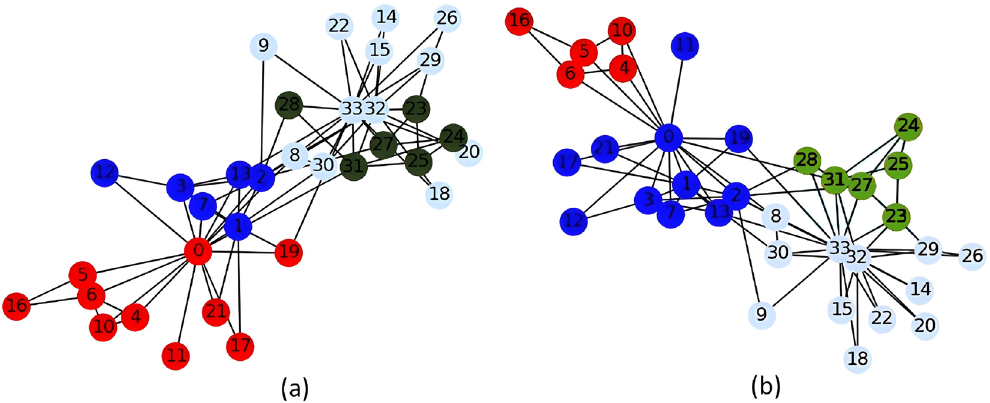
Figure 2. Community detection for the Zachary karate club graph using Louvain Community Detection Algorithm ( a ), and using Leap Hybrid Solver ( b ). We can observe that the assignment to communities differs for these 2 methods in the red and blue